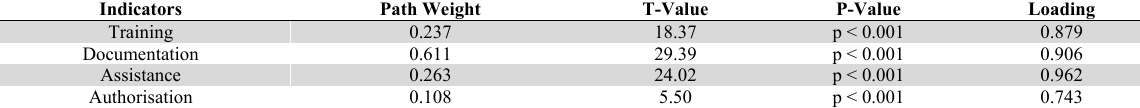
Path coefficients, significance and loadings for the second-order formative IS-Support Indicators